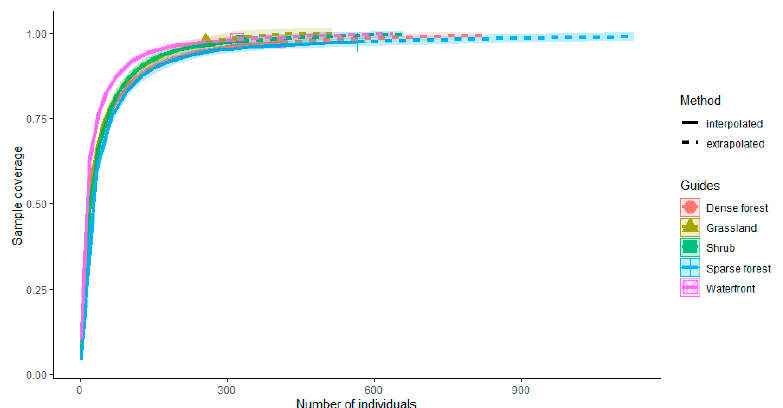
Figure 5. Sample completeness curves of bird communities in different vegetation habitats in urban mountain parks. The filled graphs (triangles, circles, etc.) represent the sample coverage.